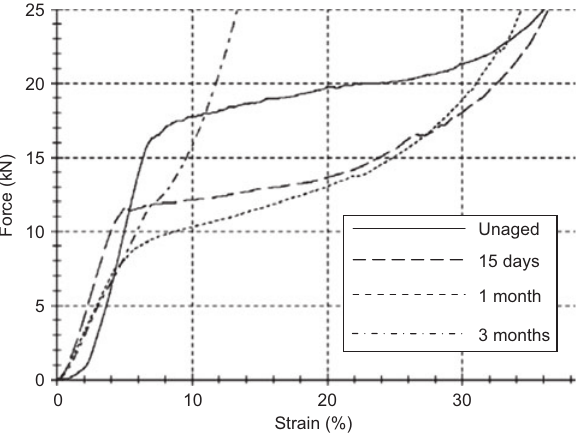
Figure 8 Acoustic emission activity of MS3 aged at 100 ° C [num- ber of hits vs. load